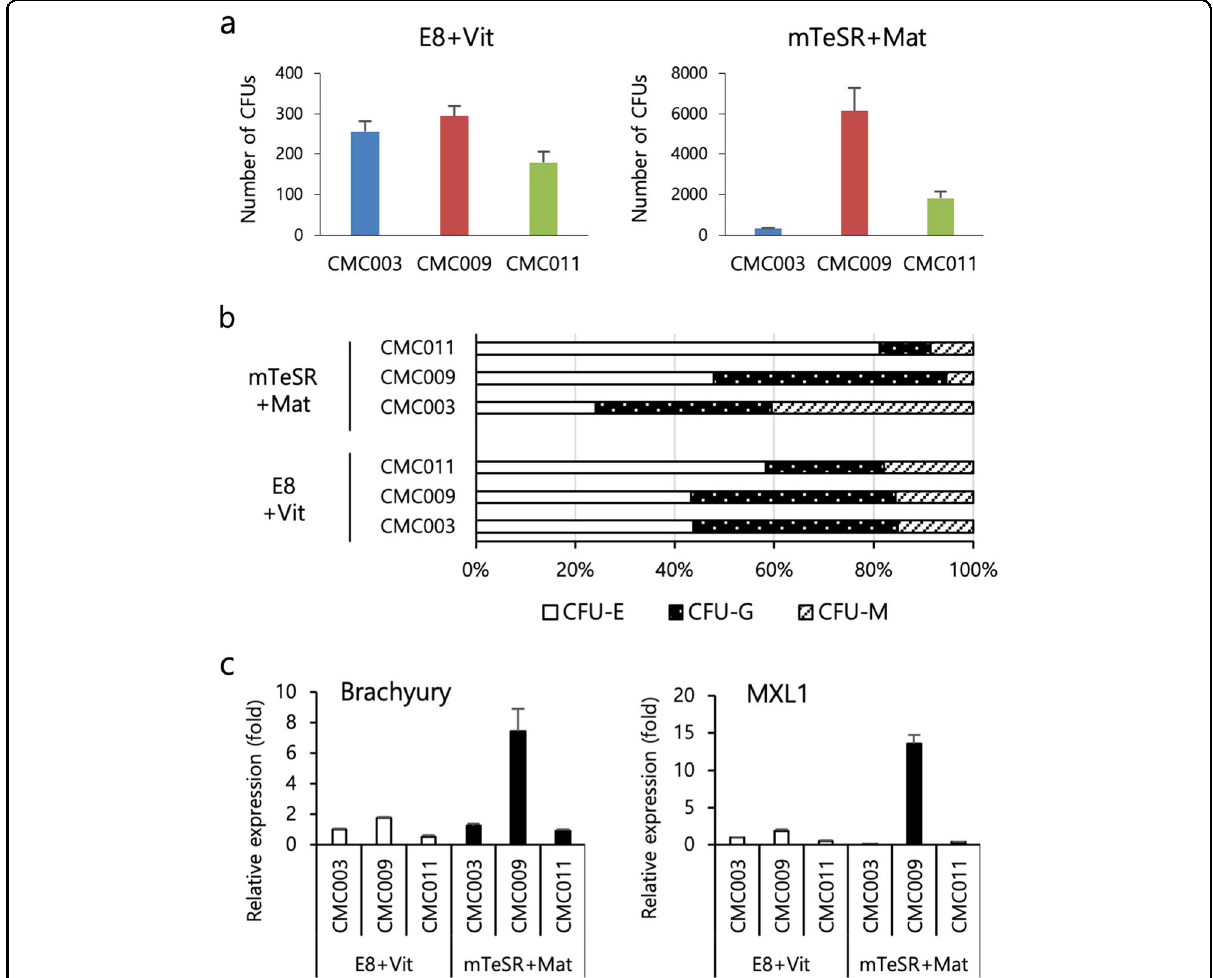
Fig. 3 Comparison of hematopoietic progenitor capacity to generate colonies. a Assessment of hematopoietic progenitor capacity of hiPSCs maintained under E8 + Vit vs mTeSR + Mat culture conditions. b Distribution of CFU subtypes. c qPCR analysis for Brachyury and MIXL1 transcripts in undifferentiated hiPSC cultures. The bars indicate the mean ± SD. CFU-E, erythrocyte; CFU-G, granulocyte; CFU-M,